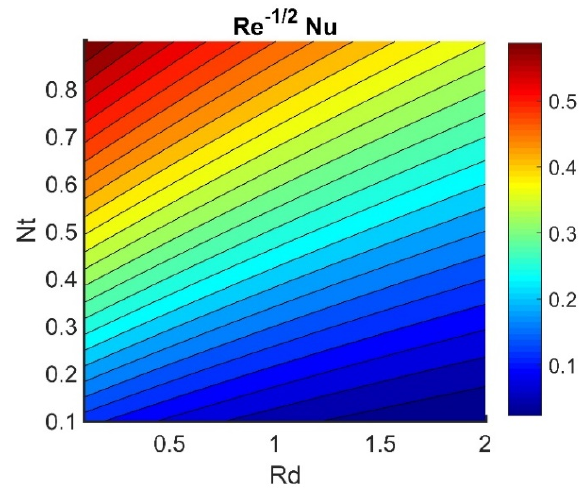
Figure 29. Impact of Nt and Rd on Re − 1/2 Nu .